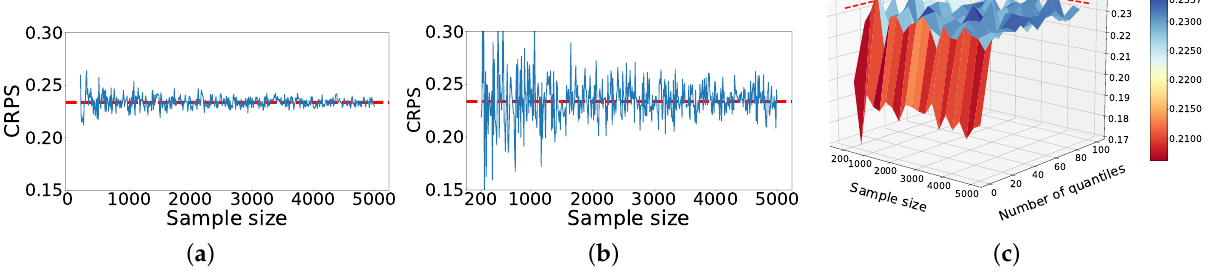
Figure 1. The effect of sample size on precision of CRPS approximation using different methods: ( a ) Empirical CDF. ( b ) Sample estimation. ( c ) Quantile based. We can see that all